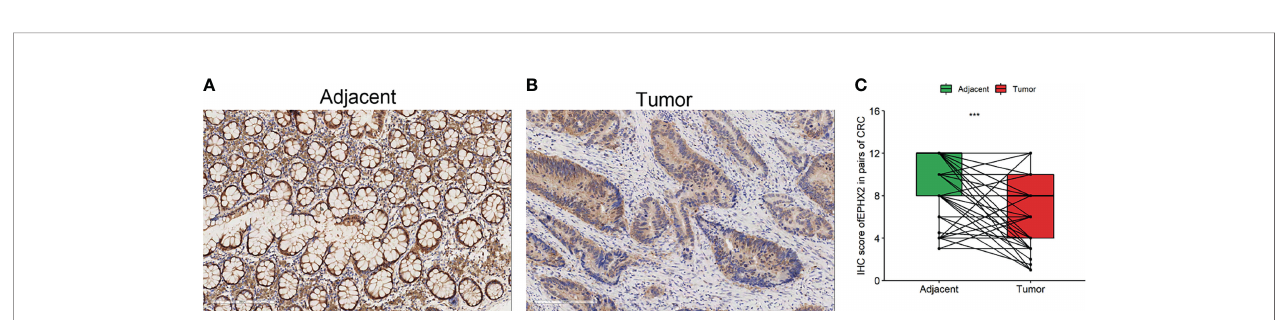
FIGURE 5 | The protein expression pro fi le of EPHX2 in human CRC tumor tissues (tumor) and adjacent normal tissues (adjacent). (A) The expression of EPHX2 in human CRC tumor tissues. (B) The expression of EPHX2 in adjacent normal tissues. (C) The expression of EPHX2 protein pro fi le was signi fi cantly lower in tumor cells than in adjacent cells (paired t-test, n = 158, ***p < 0.001; original magni fi cation, 200×; scale bars, 200 m